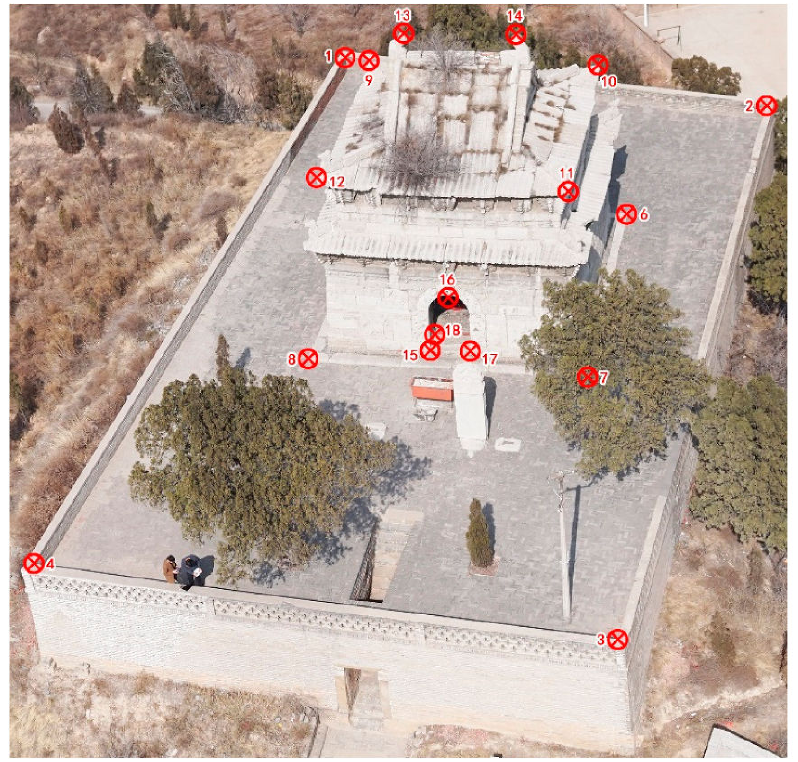
Figure 7. Layout diagram of the external control points of the Limestone